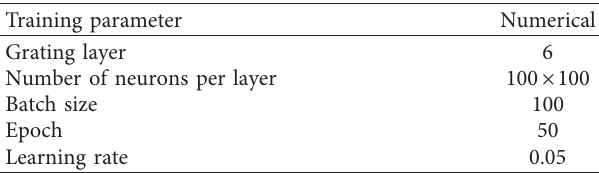
Table 6: Neural network training